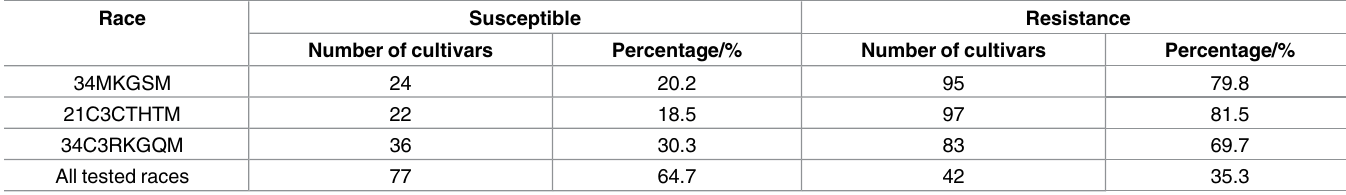
Table 3. Resistant proportion of 119 wheat cultivars to wheat stem